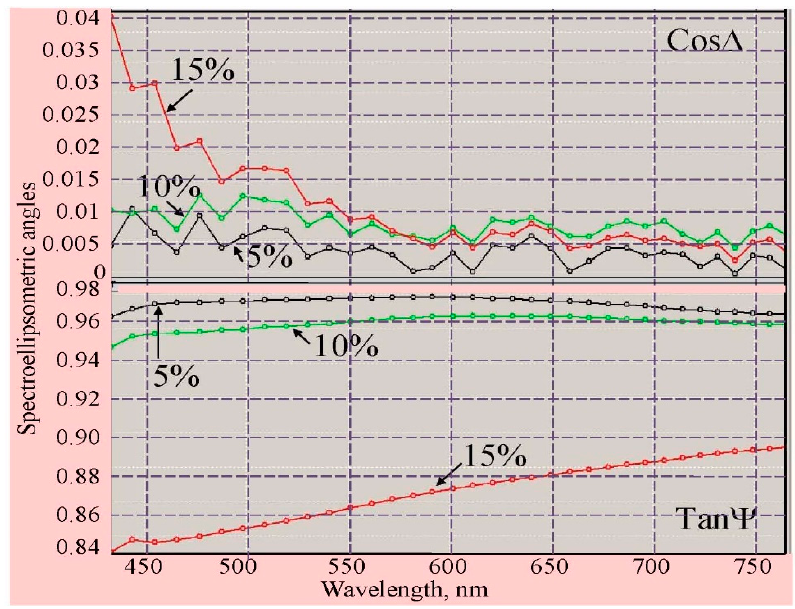
Figure 4. Spectral images of ZnSO 4 dissolved in water at concentrations shown on the